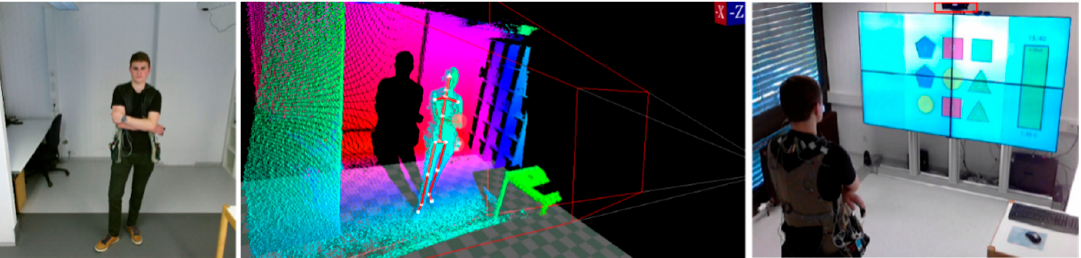
Figure 3. View of the frontal camera ( left ), depth information ( middle ) and scenery overview of the rear camera ( right ).